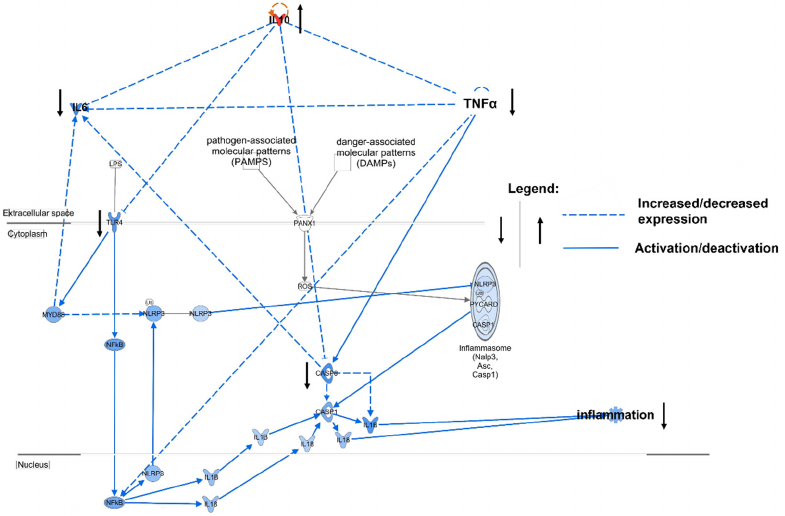
Figure 4. Inflammasome pathway relevant to ACLF predicted by IPA ® . IL ‐ 10 was identified as the main immunomodulatory cytokine in the pathway, inhibiting the inflammatory cytokines IL ‐ 6 and TNF ‐α (dotted lines indicate increased or decreased expression, while solid lines show activation; Asc, apoptosis ‐ associated speck ‐ like protein containing a CARD; CASP, caspase; IL, interleukin; LPS, lipopolysaccharides; MCP ‐ 1, monocyte chemoattractant protein 1; MyD88, myeloid differentiation primary response 88; NF κ B, nuclear factor kappa ‐ light ‐ chain ‐ enhancer of activated B cells; NLRP3; NLR family pyrin domain containing 3; PANX1, pannexin 1; ROS, reactive oxygen species; TLR ‐ 4, roll ‐ like receptor 4; TNF ‐α , rumor necrosis factor ‐α ).